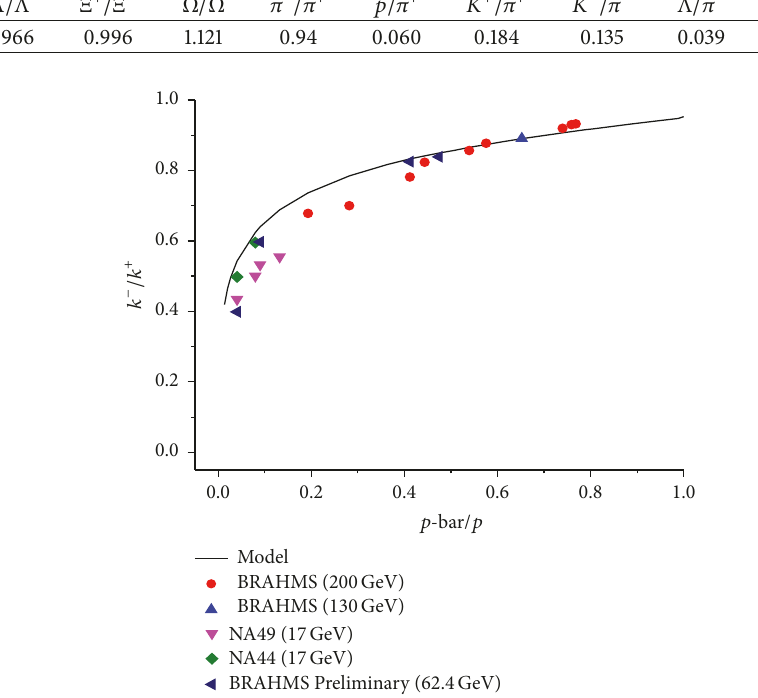
Figure 5: Correlation of 𝑘 − /𝑘 + ratio with 𝑝/𝑝 ratio at mid-rapidity for central collisions.